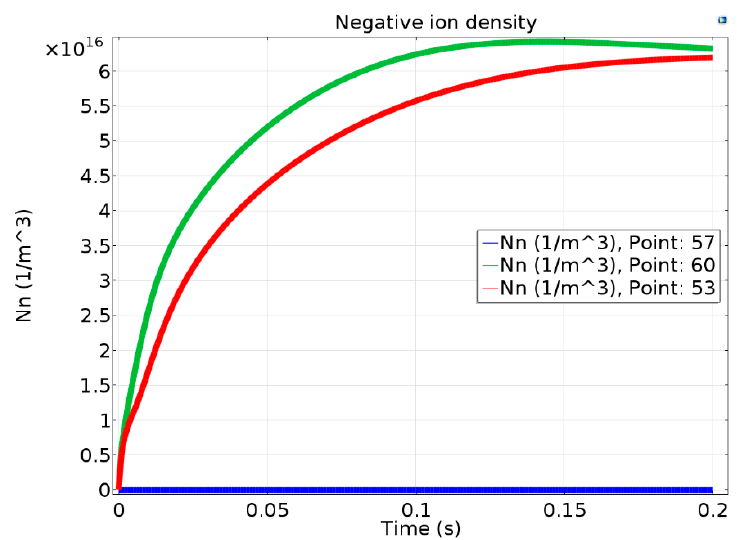
Figure 8. The negative ion density at the positive electrode (point 58), the negative electrode surface (point 53), and the central point (point 60) during the discharge.